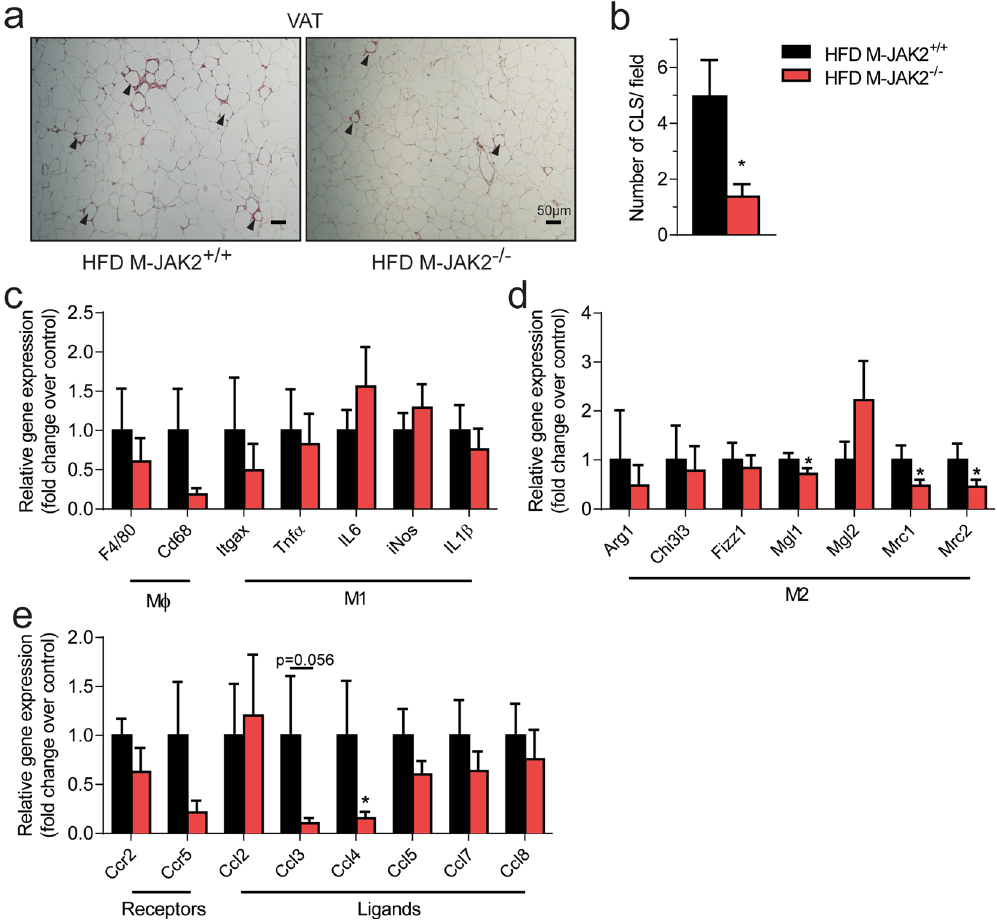
Figure 4. Decreased CLS and inflammation in VAT of HFD fed M-JAK2 − / − mice. ( a ) Representative micrographs of macrophage marker F4/80 stained VAT sections of HFD-fed M-JAK2 + / + and M-JAK2 − / − mice; crown-like structure (CLS) are indicated by arrowheads. ( b ) Quantification of CLS from VAT sections in at least 15 fields at 100X (n = 7–8). mRNA expression in VAT from HFD-fed M-JAK2 + / + and M-JAK2 − / − mice for ( c ) macrophage (M φ ) and M1 markers, ( d ) M2 markers, and ( e ) chemokine receptors and its associated ligands (n = 8–11). All results are mean ± SEM; * p <